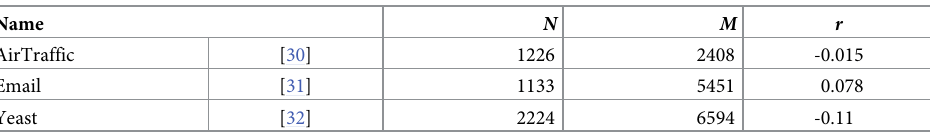
Table 2. Properties of real